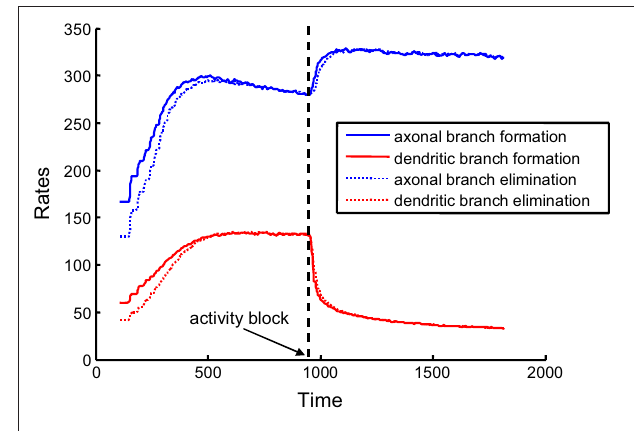
FIGURE 6 | Rates of branch additions and retractions before and after activity block. The time dependence of axonal (blue) and dendritic (red) dynamics is shown for when axons implement the activity-independent synaptotropic branching strategy and dendrites use Hebbian branching strategy. This combination of branching strategies is optimal. The rates of branch additions (solid curves) and retractions (dotted curves) increase for axons and decrease for dendrites after the activity strength is set at zero (arrow) during simulation. In this simulation, the costs of dendritic and axonal branch lengths are unequal, so as to produce shorter